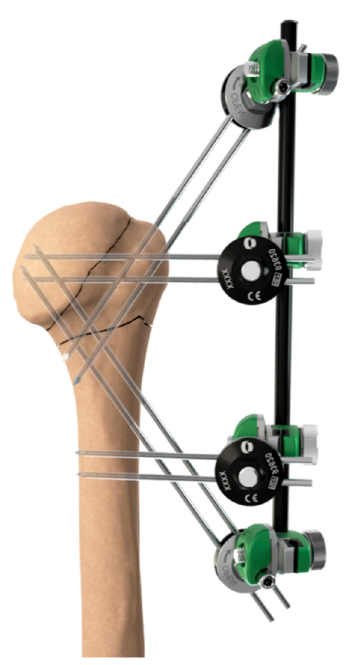
Figure 2. Drawings depicting a left three-part posterior fracture-dislocation of the humeral head with composite tuberosity shield fragment. Frontal ( a ) and lateral ( b ) views.